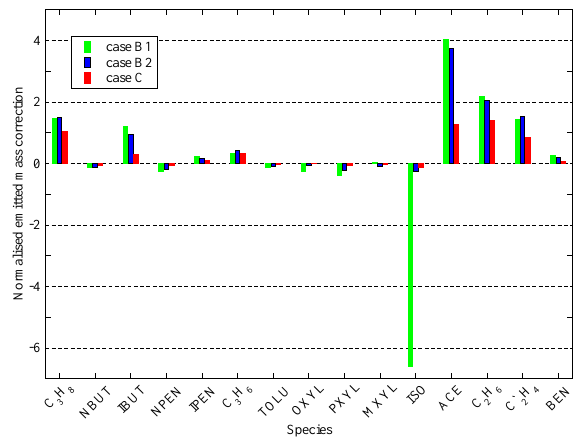
Fig. 4. Time evolution of the horizontal mean over the whole do- Fig. 5. The total emitted mass correction, normalised with respect main of OH hourly concentrations for different levels (ground level Fig. 5. The total emitted mass correction, normalised with respect to the total emitted mass of the EMEP to the total emitted mass of the EMEP inventory for cases B1, B2 in green, third level in blue and top level in red). Full lines are used inventory for cases B1, B2 and C. The normalised emitted mass correction represents the correction to the and C. The normalised emitted mass correction represents the cor- for a priori simulations and crossed ones are used for a posteriori rection to the emitted mass 1E divided by the original emitted mass emitted mass ∆ E divided by the original emitted mass E 0 . Therefore, there is no correction if ∆ E/E 0 is equal simulations. The dotted lines represent the standard deviation com- E 0 . Therefore, there is no correction if 1E/E 0 is equal to 0. If it is to zero. If it is equal to 1, the corrected emitted mass is twice the original emitted mass. If it is equal to -1, the puted for the corresponding levels. equal to 1, the corrected emitted mass is twice the original emitted corrected emitted mass is zero. If it is less than -1, then the corrected emitted mass is negative. mass. If it is equal to − 1, the corrected emitted mass is 0. If it is less than − 1, then the corrected emitted mass is